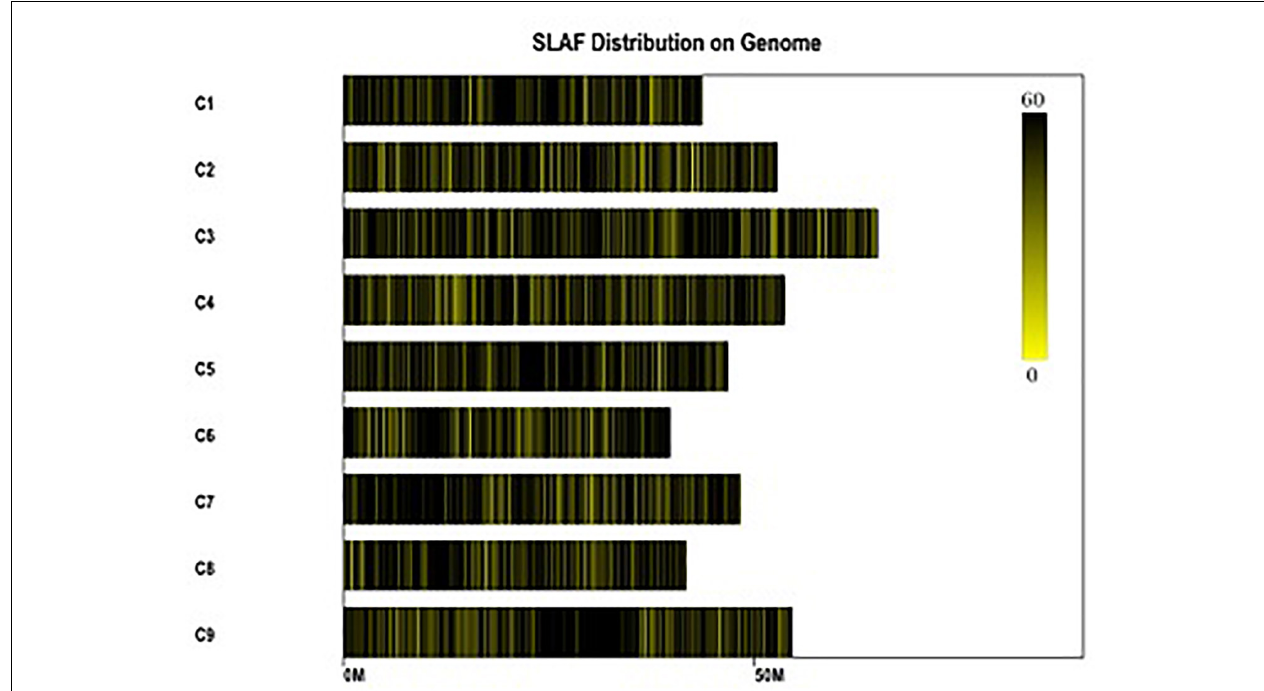
FIGURE 2 | Distribution of the total SLAFs on the reference genome TO1000. The x -axis and the y -axis represent chromosome length and code, respectively. Each yellow bar stands for a chromosome, and deeper color from yellow to black means more SLAFs on the corresponding location.